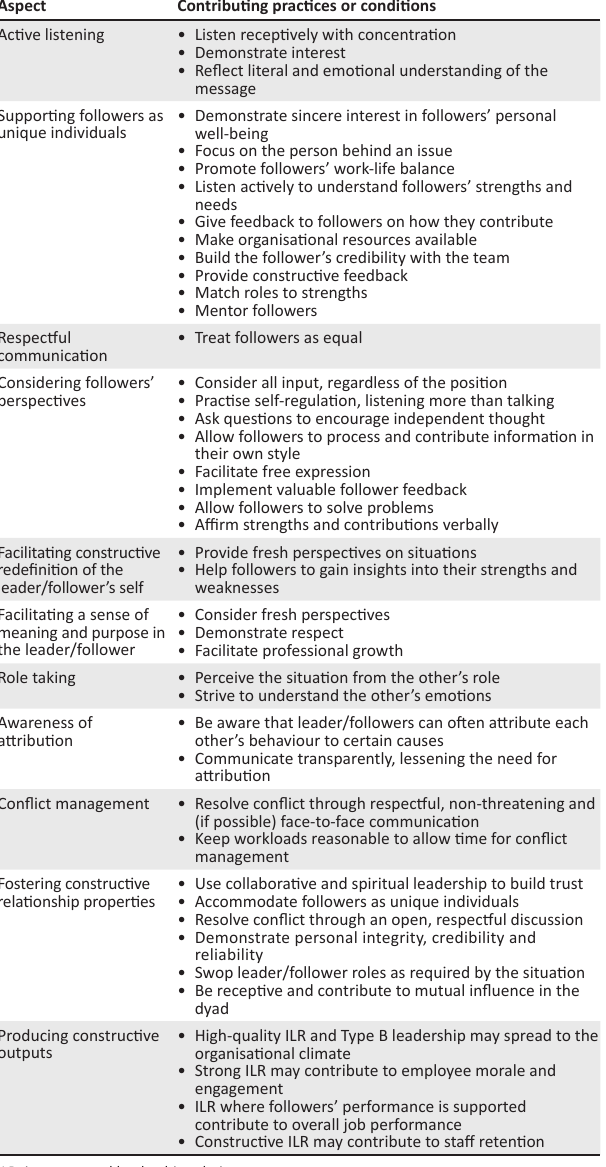
TABLE 4: Constructive interpersonal leadership